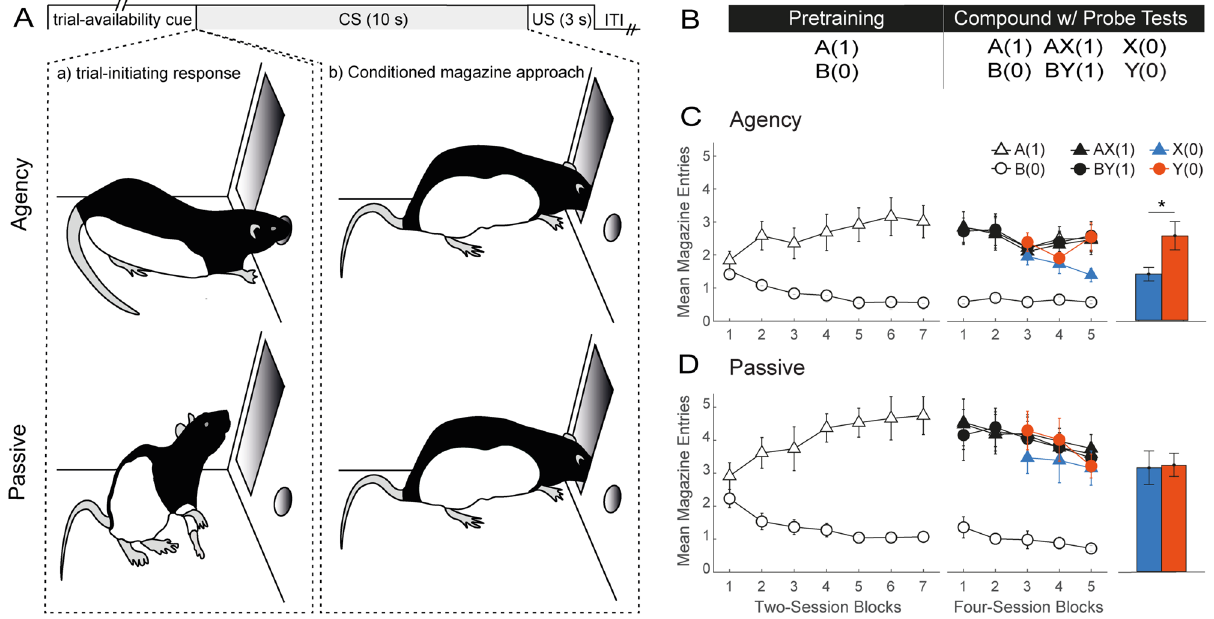
Figure 1. Agency over learning rescues competitive credit assignment from the deleterious effects of massed training in a blocking task. ( A ) Trial structure in this and the remainder of the studies. On each trial offer, a nose-port light was presented in both groups signaling trial availability to Agency rats. A trial-initiating response (nose poke) by an Agency rat immediately resulted in a 10-s cue being presented to that rat as well as to its yoked animal in the Passive group. On reinforced trials, a sucrose US was presented at dipper magazine following cue offset. Trial offers were separated by a 10-s variable intertrial interval (ITI). ( B ) Experimental design. Letters A and B denote visual stimuli, whereas X and Y denote auditory stimuli. Digits in brackets represent the probability of reward for each trial type. The pretraining phase involved a simple discrimination between A and B. During the compound phase, these trials were interleaved with compounds AX (where A should block X) and BY (where B should not block Y), both continuously reinforced. To test for blocking (i.e., less responding to X than Y), two daily probe trials with X and Y were introduced on session 9 of the Compound phase. ( C , D ) Behavioral results in groups Agency and Passive, respectively. The left and center line plots depict performance during the Pretraining and Compound phases, respectively. The bar graphs on the right show average responding to X and Y on probe trials across the last four sessions. Conditioned responding is measured as mean number of head entries (±